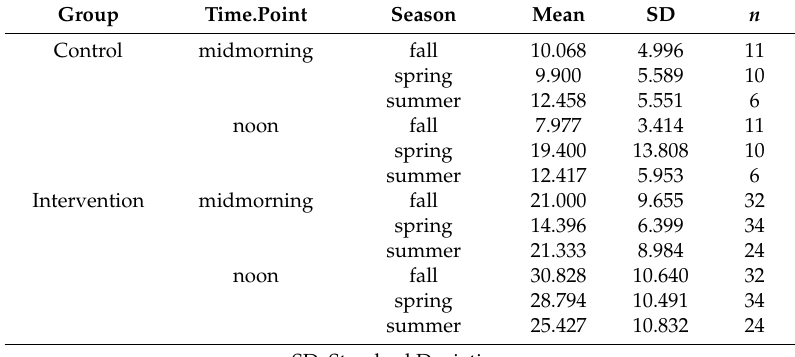
Table 3. Descriptives-Moderate-to-vigorous physical activity (MVPA) [min].